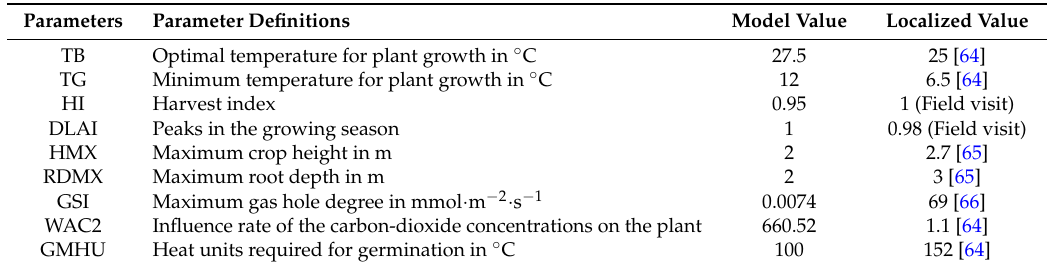
Table 2. Localization of the key parameters for simulating switchgrass yield.